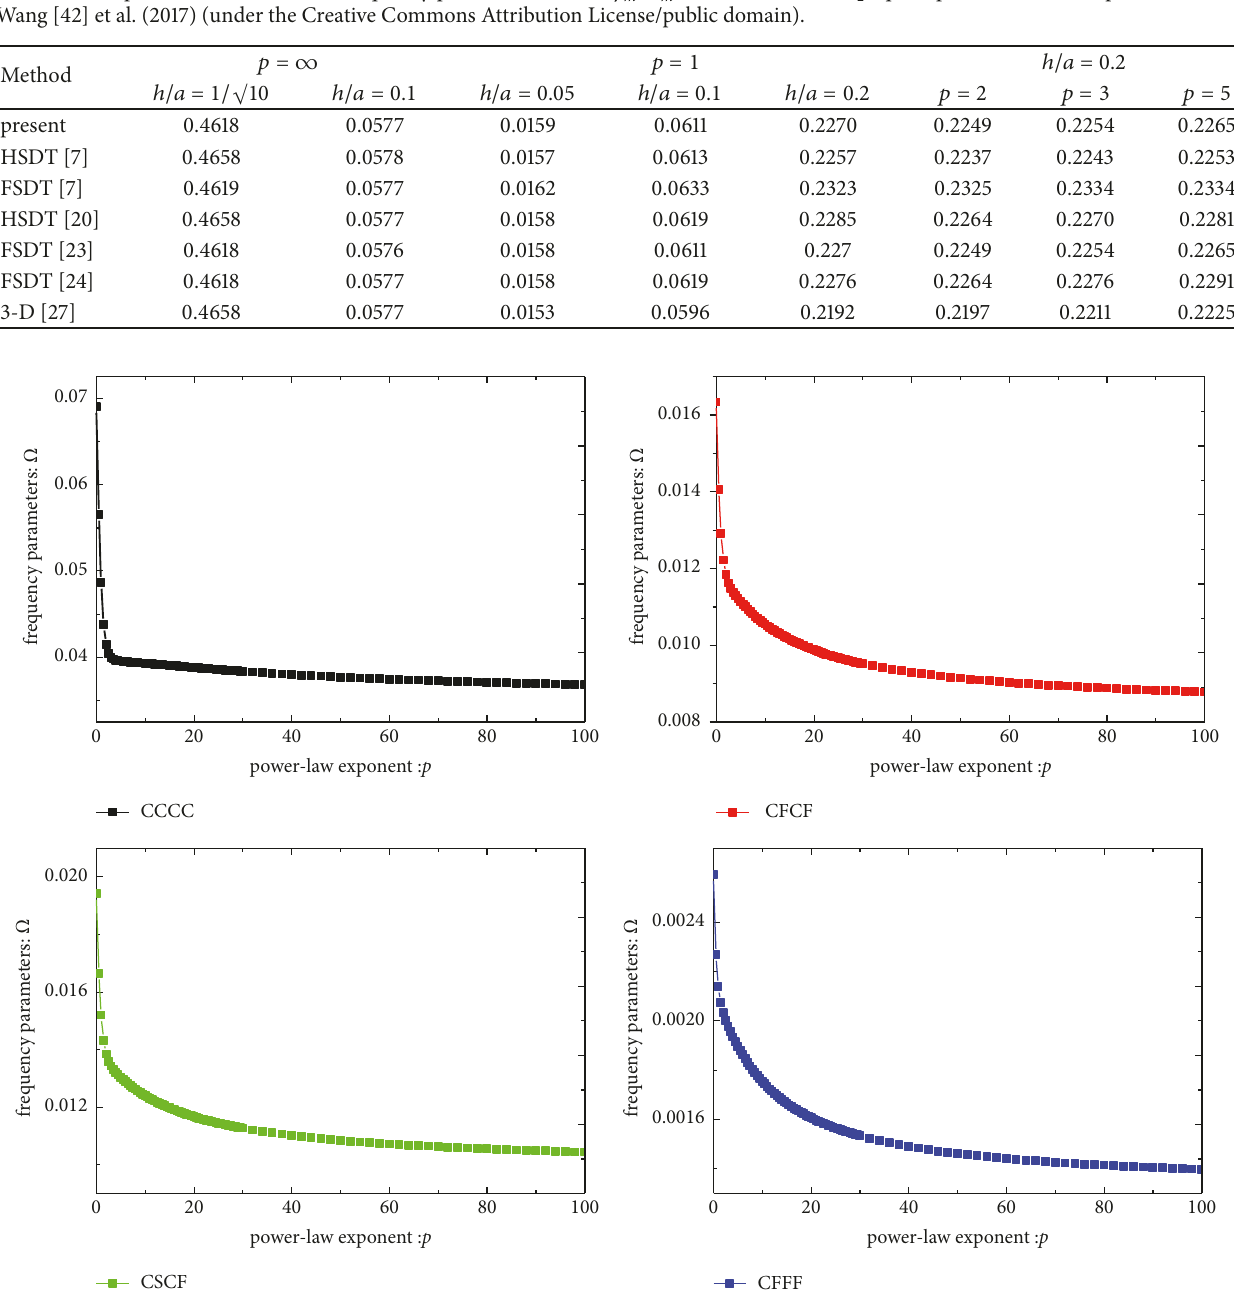
Table 8: Comparison of fundamental frequency parameter Ω = 𝜔ℎ(𝜌 𝑚 /𝐸 𝑚 ) 1/2 for SSSS Al/ZrO 2 square plates. Table 8 is reproduced from